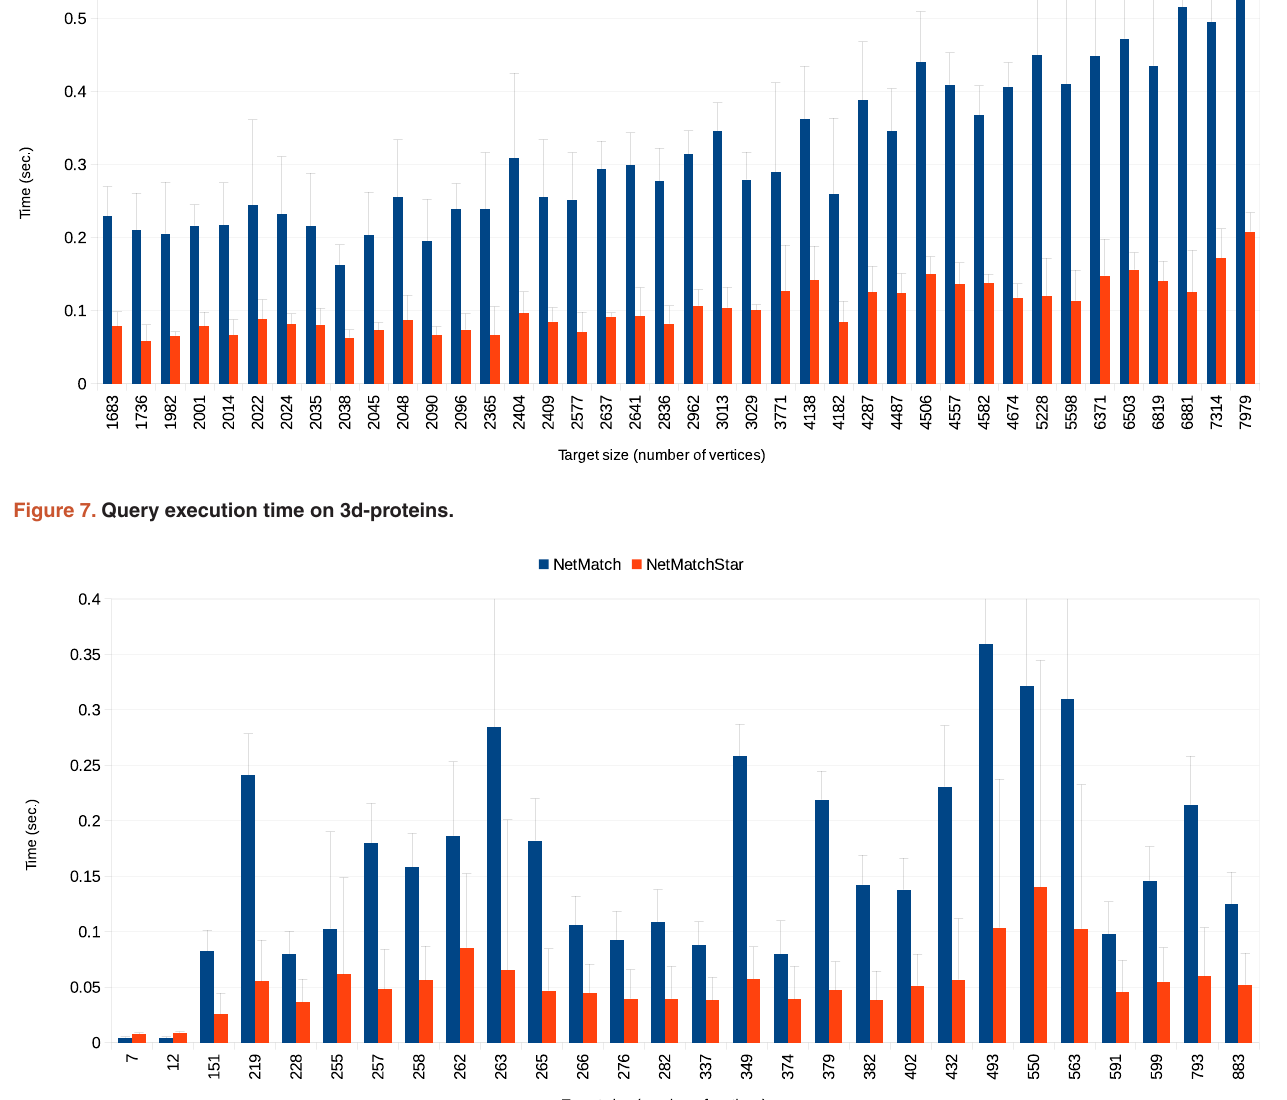
Figure 8. Query execution time on protein contact maps.